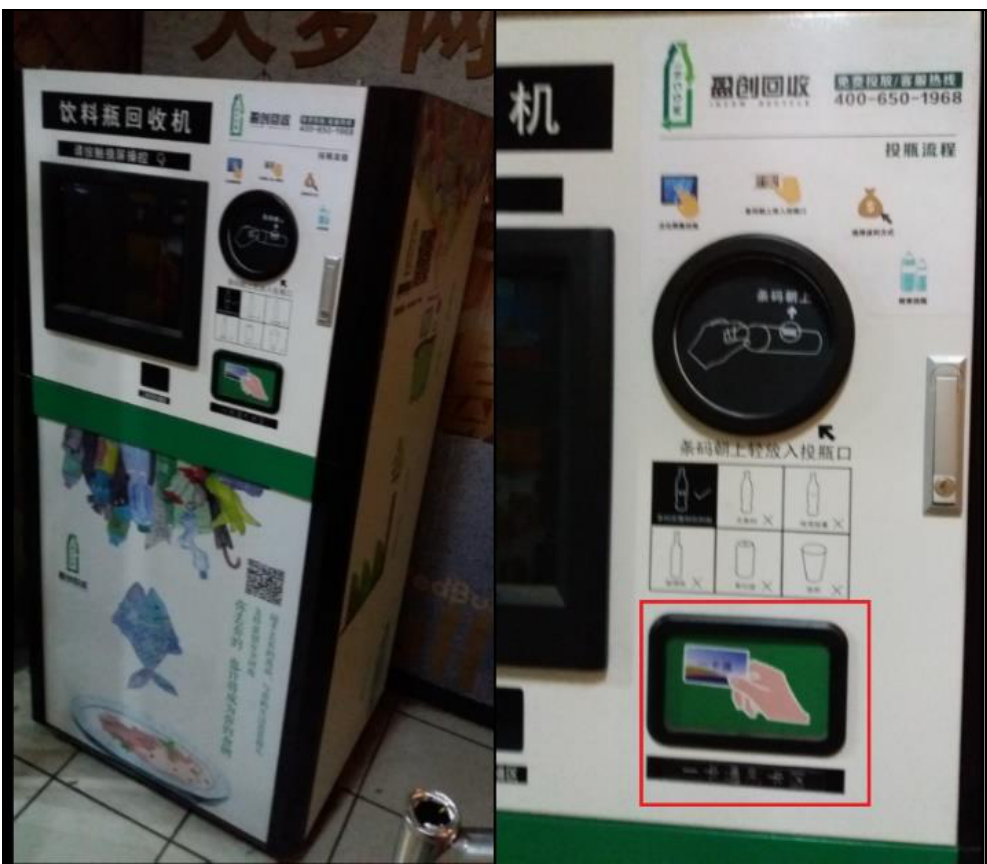
Figure 10. The cash-back system for recyclables in Shanghai.